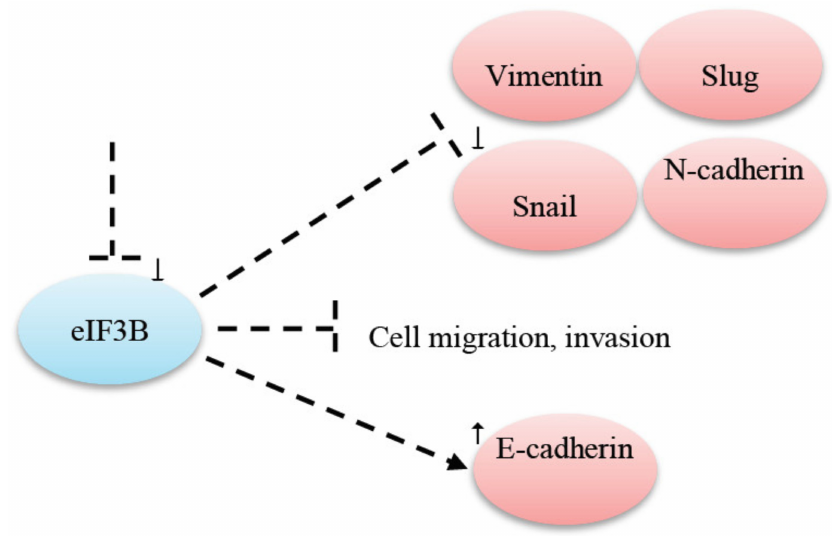
Figure 1. A knockdown of eIF3B prevented cell migration and invasion, decreased the expression of N-cadherin, Snail, Slug and Vimentin and increased the expression of E-cadherin [74].